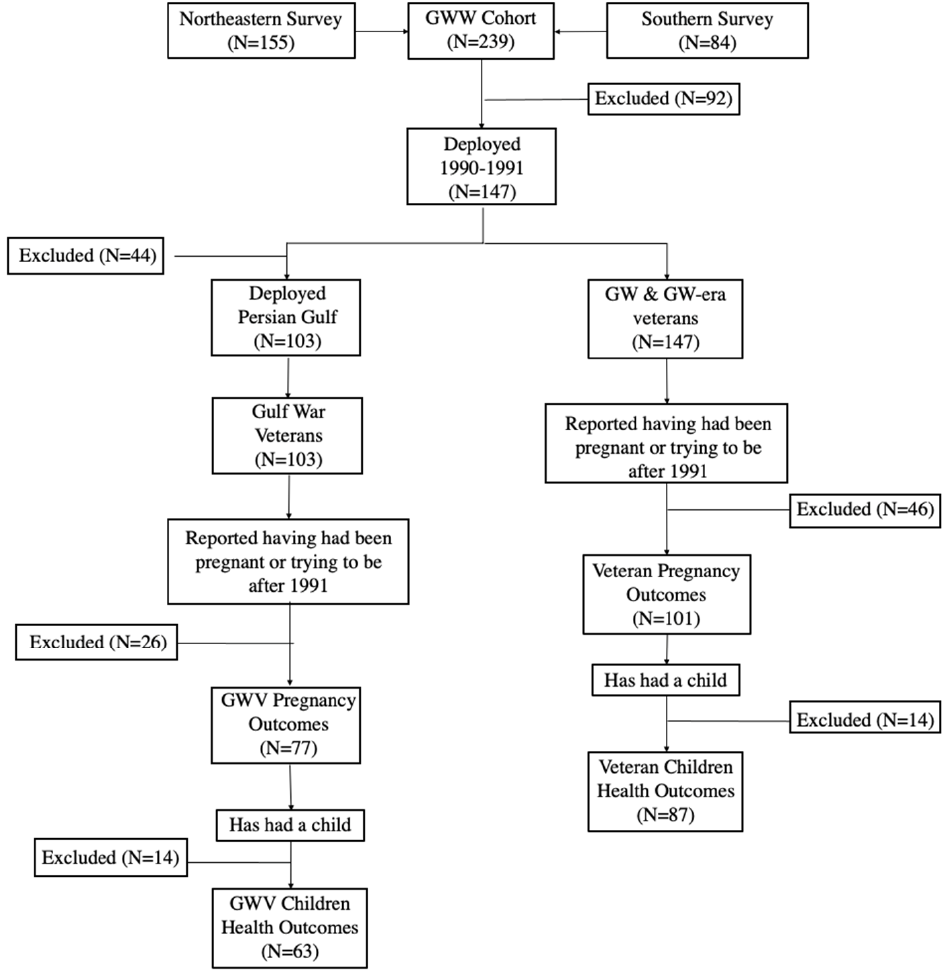
Figure 1. Schematic of the study population .